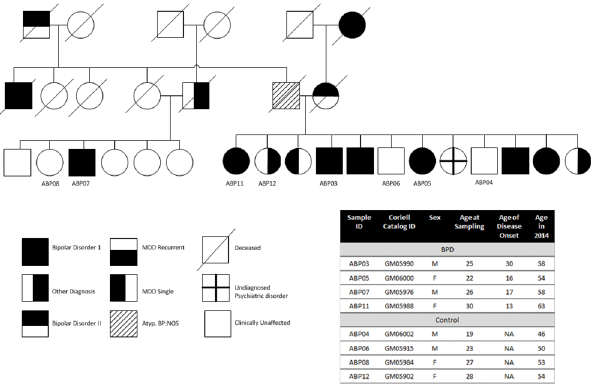
Fig 1. Selection of fibroblasts from the NIGMH repository for generation of iPSCs. Fibroblasts from patients diagnosed with Type I BPD and their sibling controls of Old Order Amish pedigree were obtained from the NIGMS Human Genetic Cell Repository at Coriell Institute for Medical Research for reprogramming into iPSCs using the Sendai virus method. The pedigree has been updated according to DSM-IV. Circles and squares represent females and males, respectively. MDD = Major Depressive Disorder; Atyp. BP: NOS = Atypical Bipolar (not otherwise specified). Other diagnosis for the patient from which ABP12 was derived was post-partum